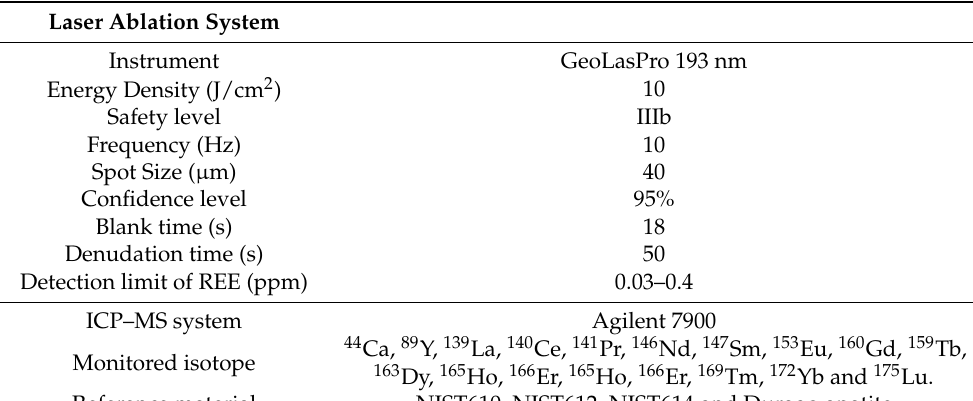
Table 1. Summary of instruments, analytical conditions and reference materials used for the LA-ICP– MS measurements.